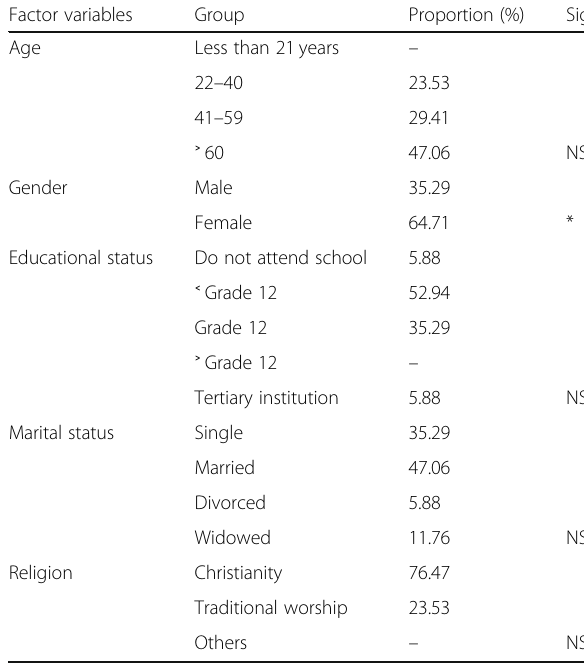
Table 5 Chi-square test result of factors that influence small- scale farmers ’ willingness to consume flavored yoghurt made from goat milk